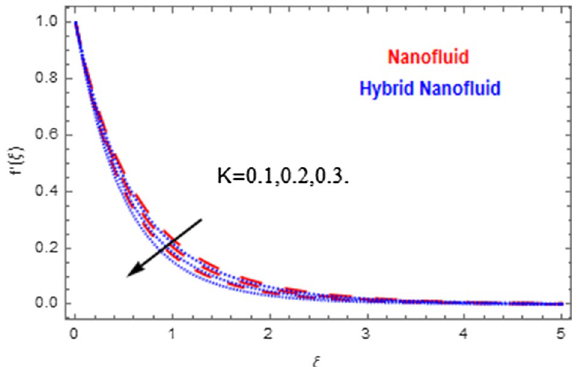
Figure 9. Variation in velocity field of nanofluid ( Al 2 O 3 ) and hybrid nanofluid ( Al 2 O 3 , Cu ) against different estimations of K .